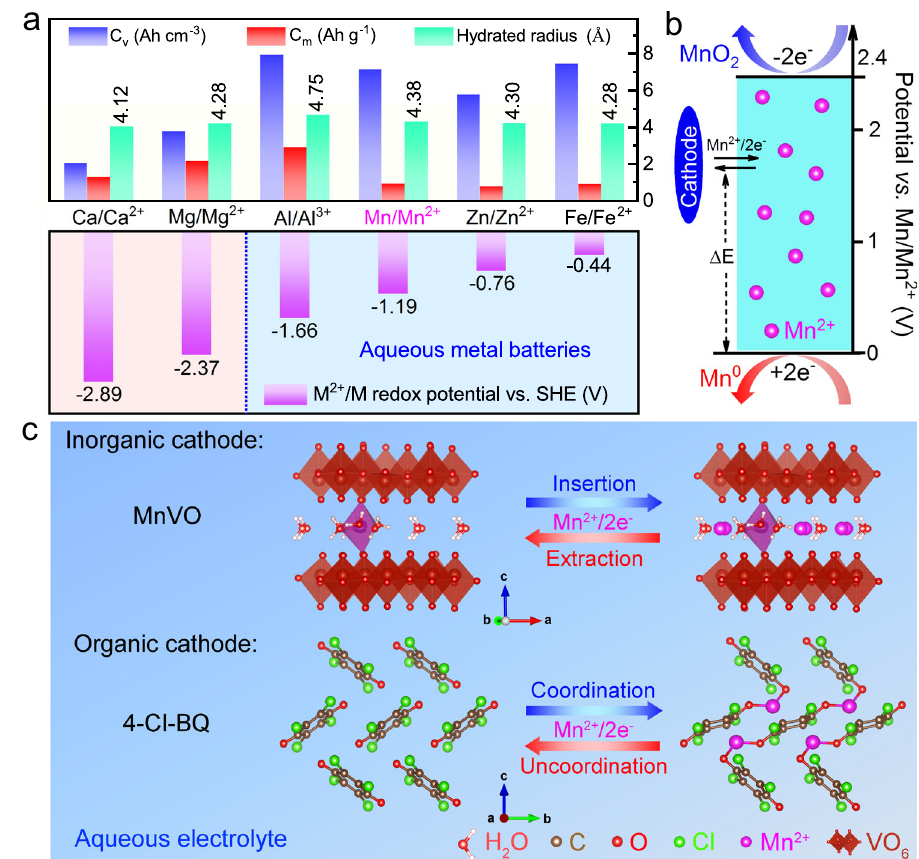
Fig. 1 Properties of Mn 2 + ions in aqueous electrolytes. a Comparison of the theoretical capacity, hydrated ionic radius, and M/M 2 + redox potential vs. SHE of various multivalent metals, including Ca, Mg, Al, Mn, Zn, and Fe. b The stable voltage window of Mn 2 + ions. c Schematic diagram of different Mn 2 + ion reaction processes in inorganic (MnVO) and organic (4-Cl-BQ)